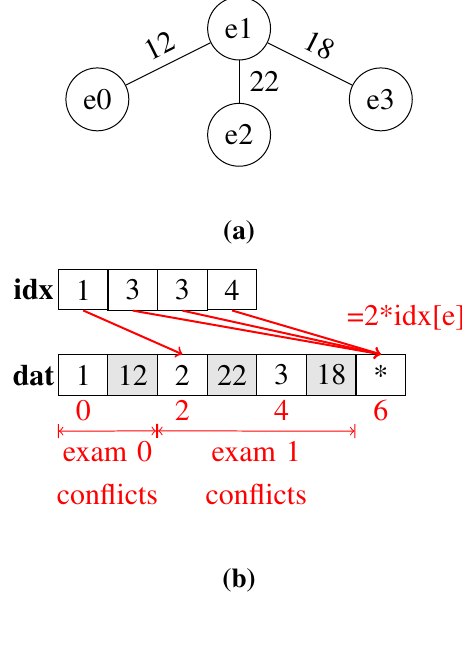
Figure 3. ( a ) Conflict graph for the problem described in the half-compressed conflict matrix figure; ( b ) half-compressed conflict matrix structure (the dat array contains tuples of the exam in conflict (white) and the conflicting number of students